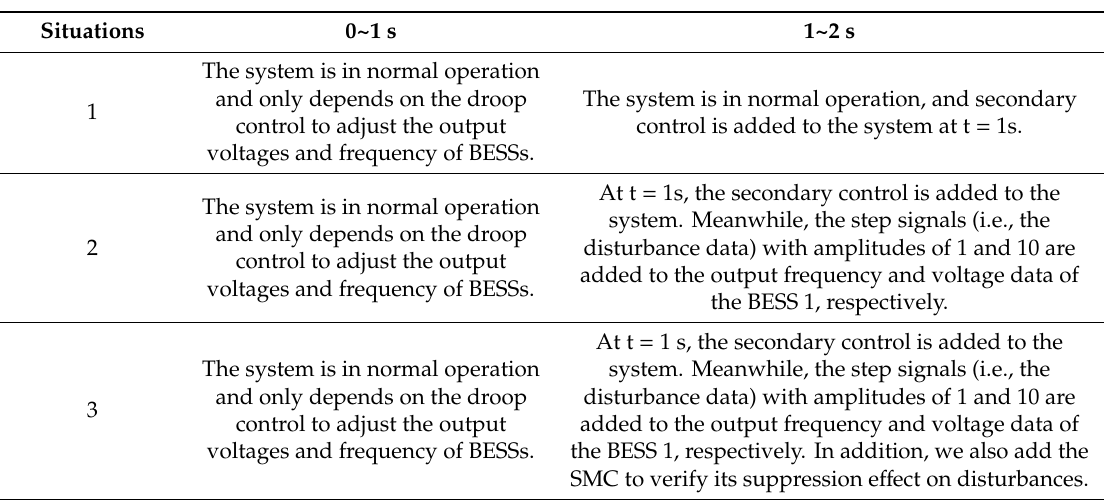
Table 6. The control process of